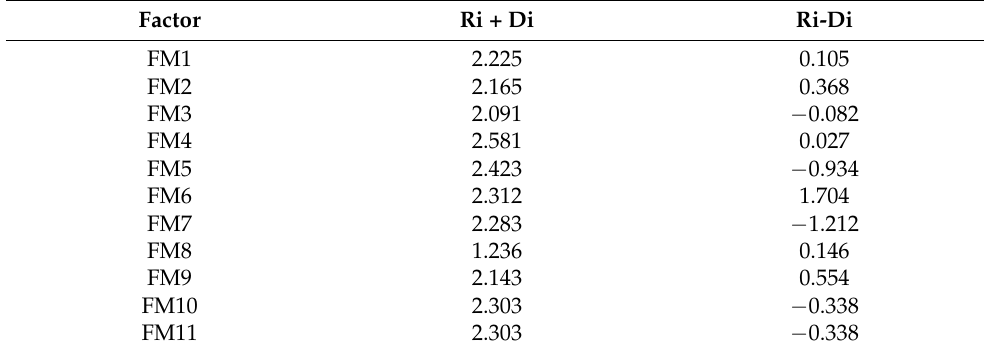
Table 6. The influence of the degree of